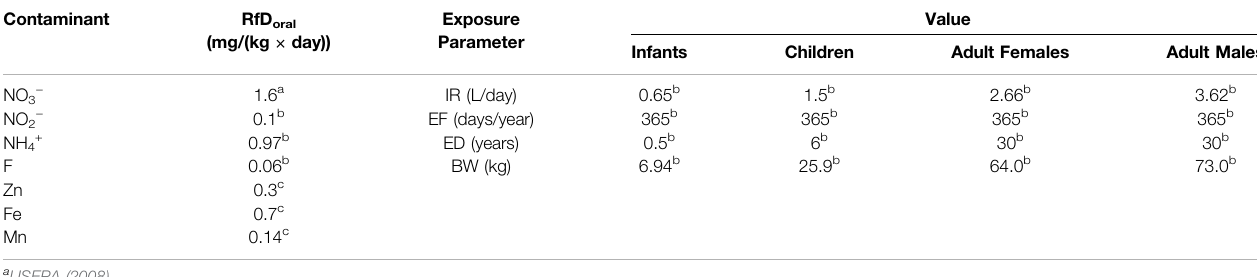
TABLE 1 | Key parameters involved in the human health risk assessment. Contaminant